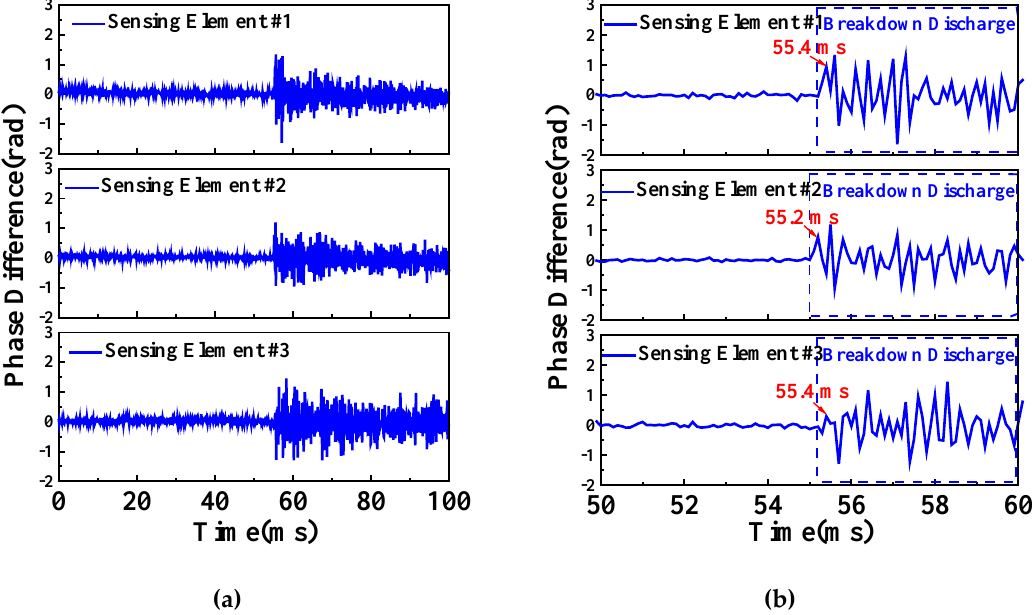
Figure 9. Detected signals of sensing elements #1, #2, and #3 at a pulse repetition rate of 10 kHz from ( a ) 0–100 ms and ( b ) 50–60 ms